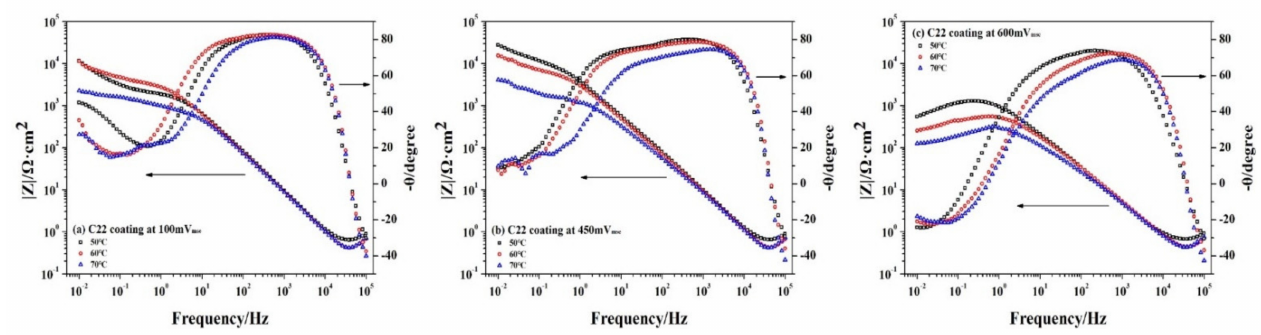
Figure 9. Bode plots for the C22 coating in 50 wt.% H 2 SO 4 at 100 mV mse ( a ), 450 mV mse ( b ) and 600 mV mse ( c